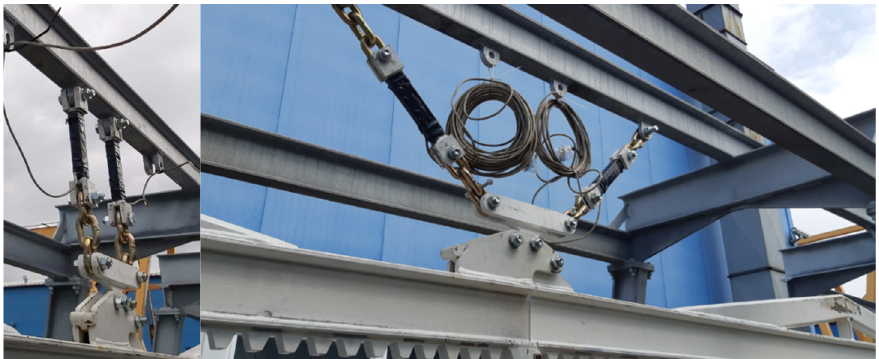
Figure 3. Force transducers installed in the rail suspensions [7].